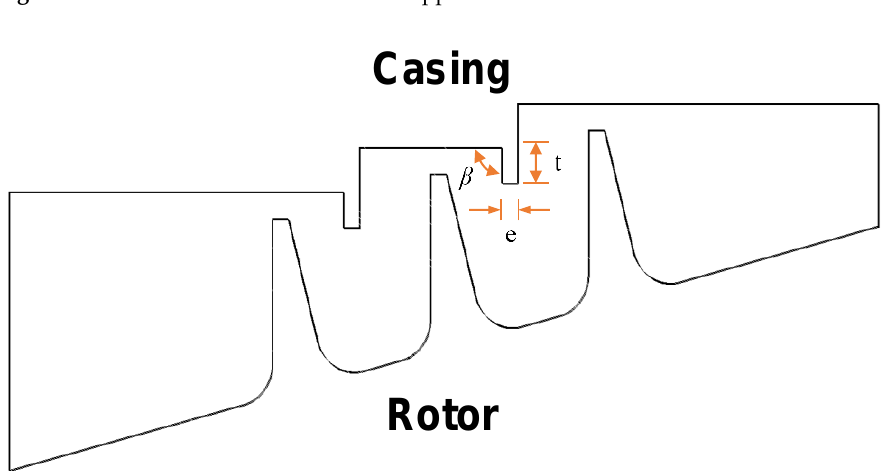
Figure 2. Schematic of the ribbed seal.